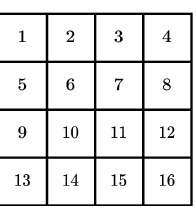
Figure 11. A grid of 4 × 4 cells for a two-dimensional